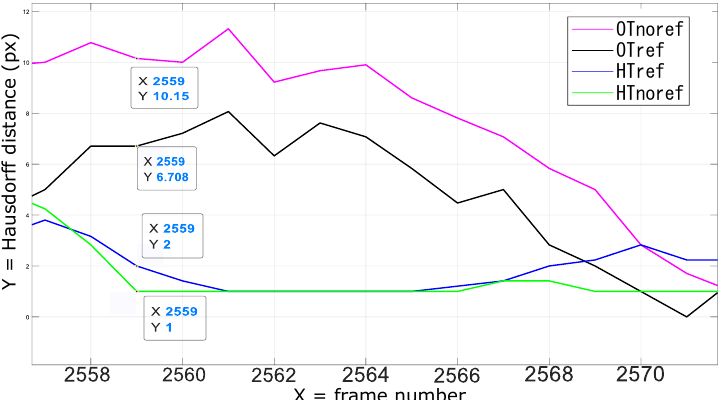
Figure 11. Overlay accuracy when ambiguity in perspective-3-point (P3P)-based optical tracking is